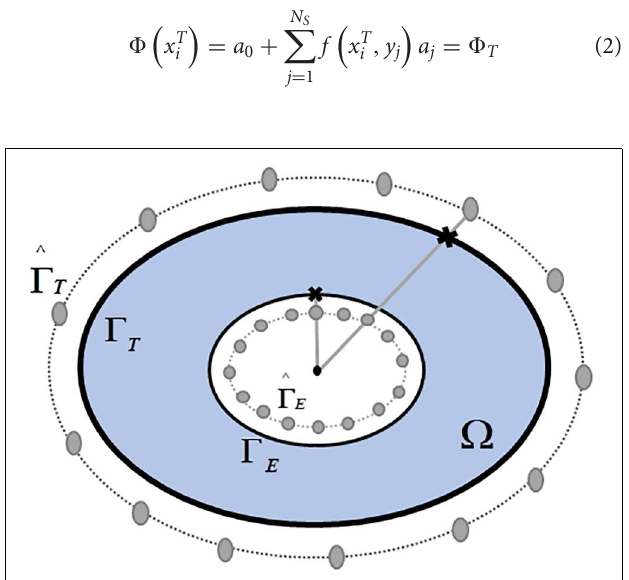
FIGURE 1 | Schematic configuration of the pseudo-boundaries [deflating 0.8 and inflating 1.2, using the experimental values accorded in Wang and Rudy (2006)]. Where (cid:48) T is the body surface, (cid:48) E the epicardial surface, c (cid:48) T is the virtual inflated body surface, c (cid:48) E the virtual deflated epicardial surface, and (cid:127) the domain of